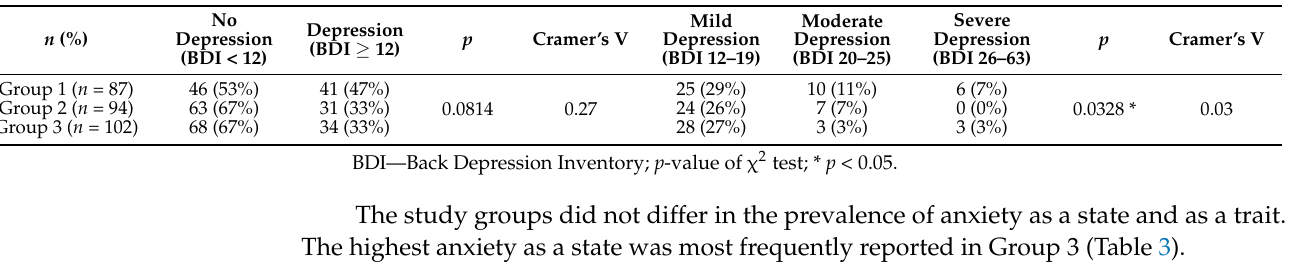
Table 2. Prevalence of depression in the three groups (the χ 2 test).